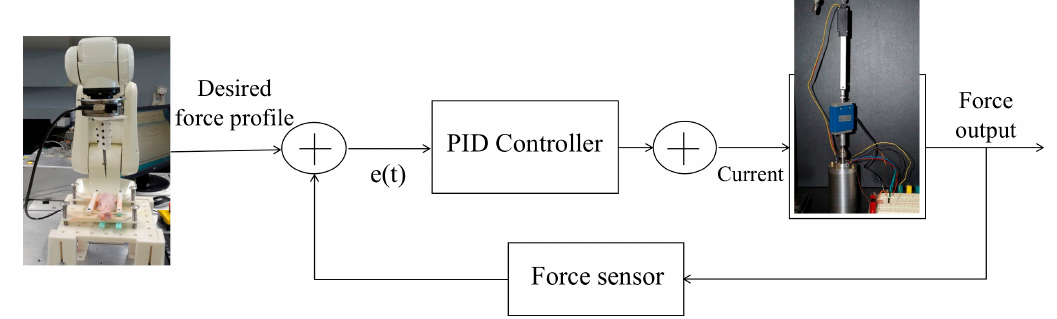
Figure 6. Control loop design using a force sensor in the feedback loop.